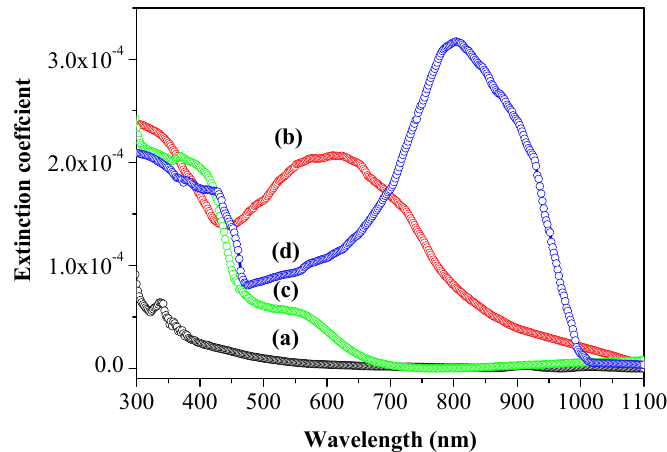
Figure 20. Extinction coefficients of doped PANI: not annealed ( a ) and annealed ( b ). Extinction coefficients of doped PANI functionalized with CNTs: not annealed ( c ) and annealed ( d ).